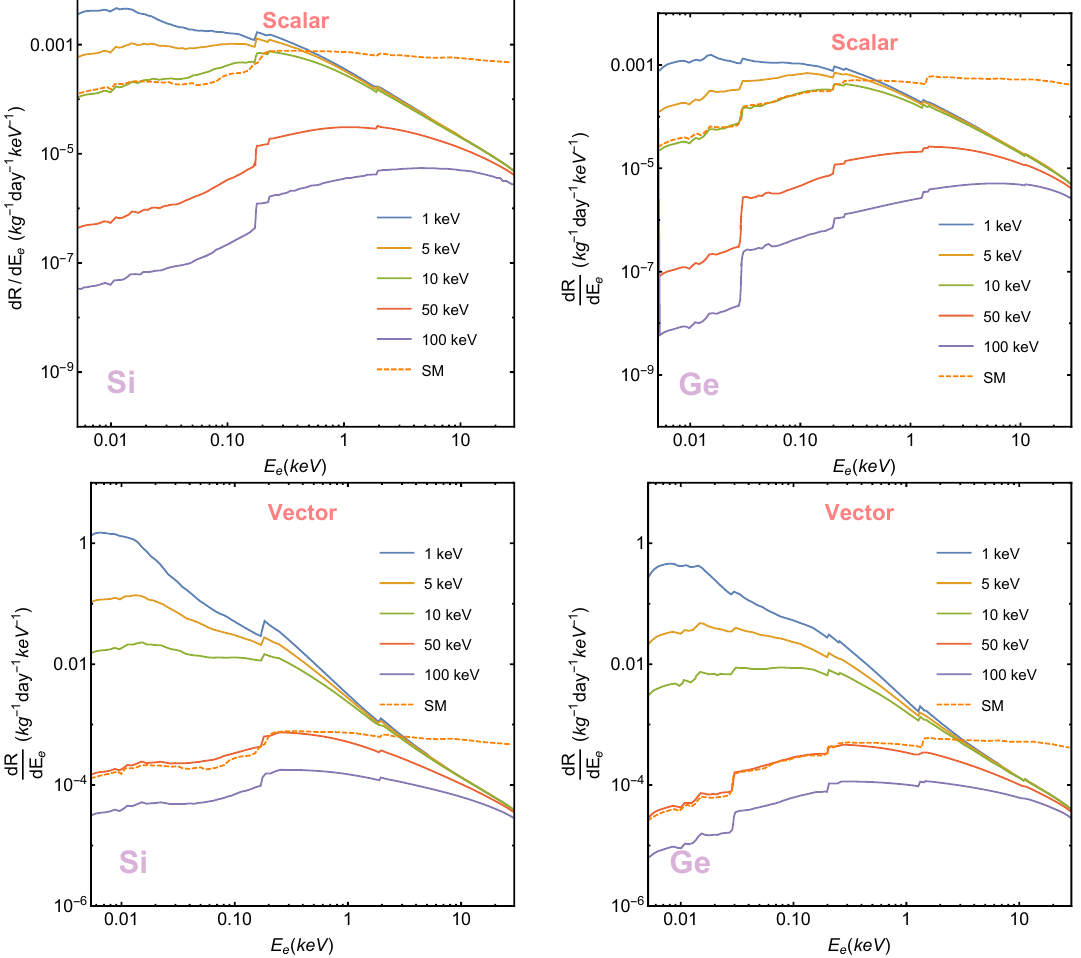
Figure 3 . Differential event rate as a function of the deposited energy E e for neutrino scattering off silicon and germanium target for various mediator masses. The appropriate atomic and crystal form factors have been